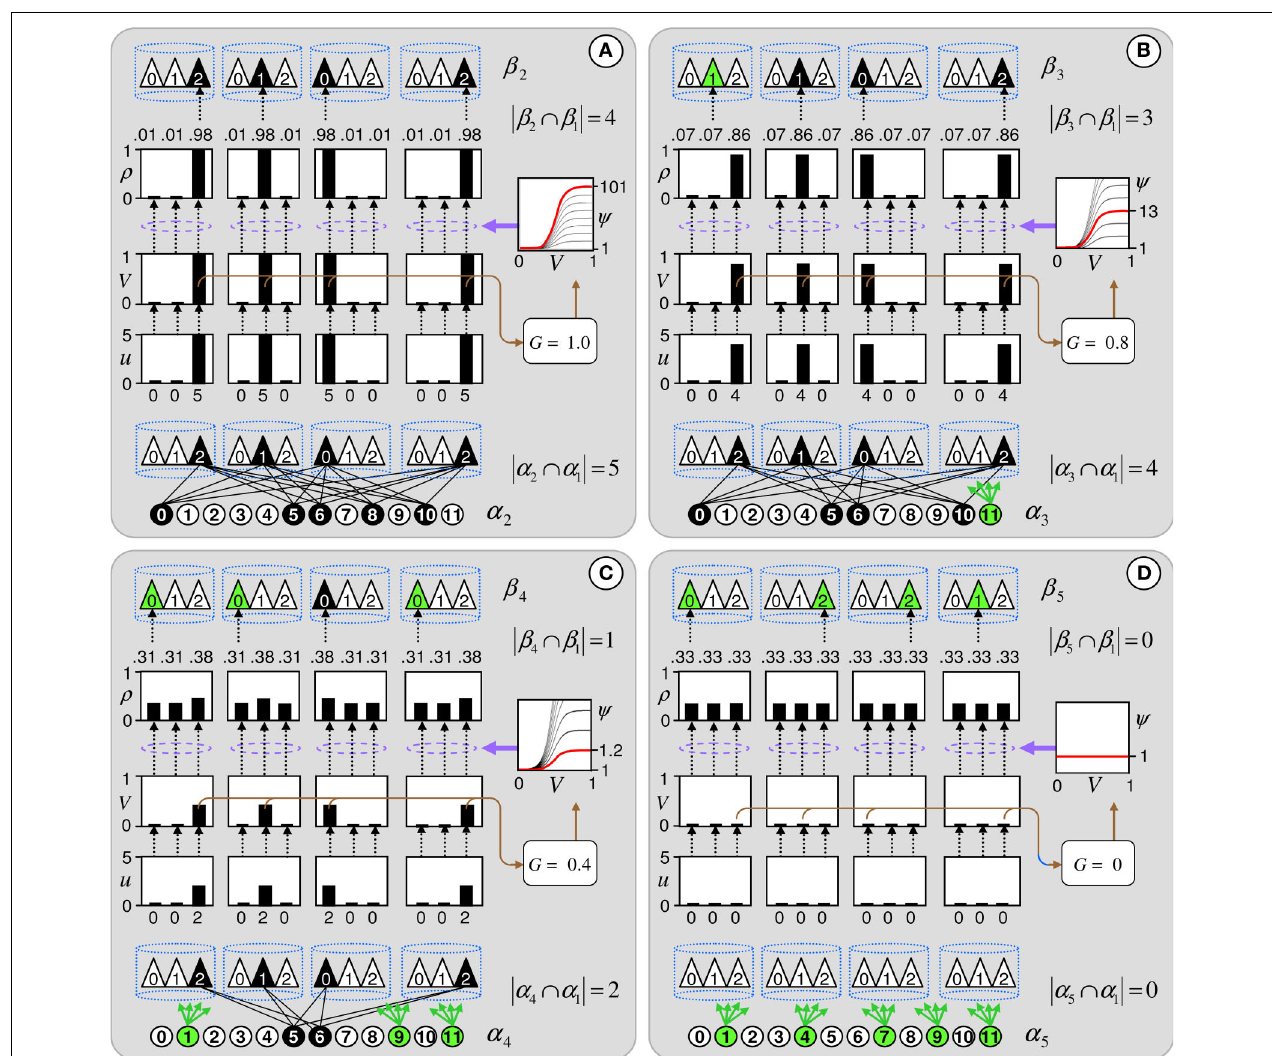
FIGURE 4 | The CSA and the SISC property. Green F1 (F2) units denote units not in common with α naïve ( w = 0) weights. See